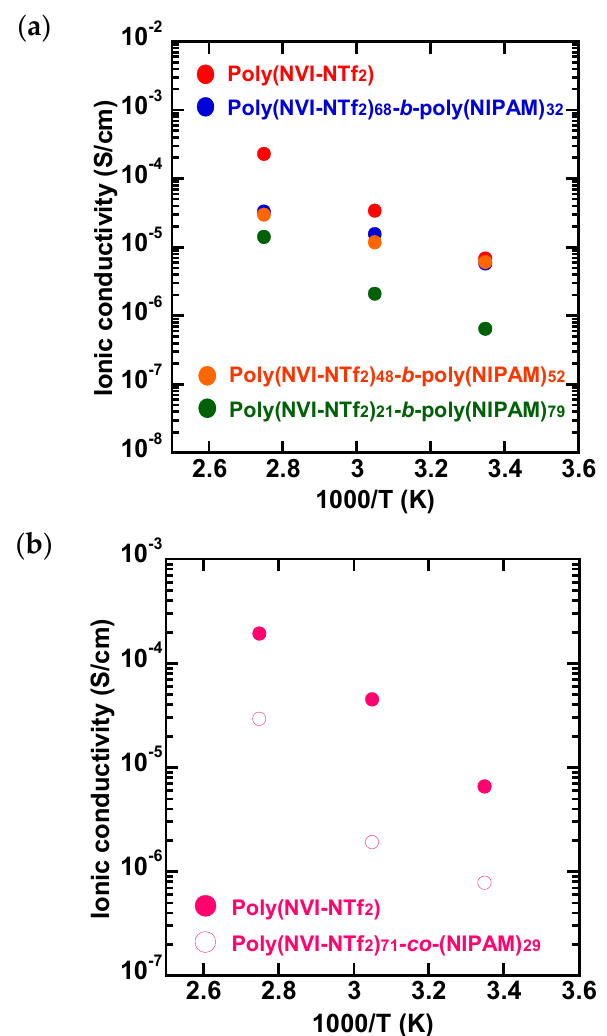
Figure 4. Temperature-dependent ionic conductivity of ( a ) poly(NVI-NTf 2 )- b -poly(NIPAM)s having different comonomer compositions and ( b ) poly(NVI-NTf 2 ) and poly(NVI-NTf 2 - co -NIPAM). A random copolymer, poly(NVI-NTf 2 - co -NIPAM), prepared by RAFT copolymerization of